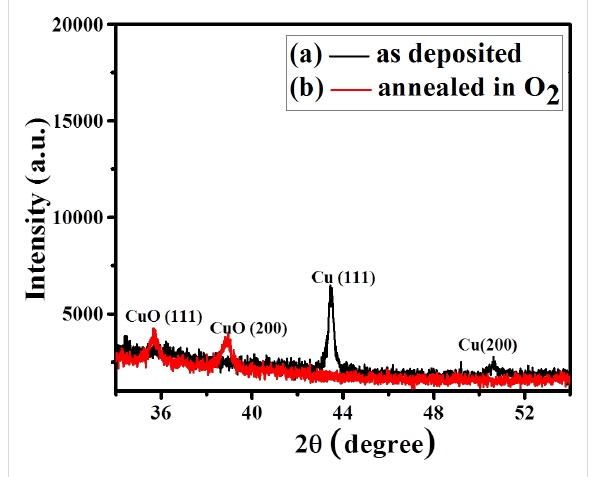
Figure 3: X-ray diffraction pattern for the (a) as-deposited copper nanoparticles on silicon substrate and (b) when the copper nanoparti- cle substrate is annealed under oxygen at 500 °C for 1